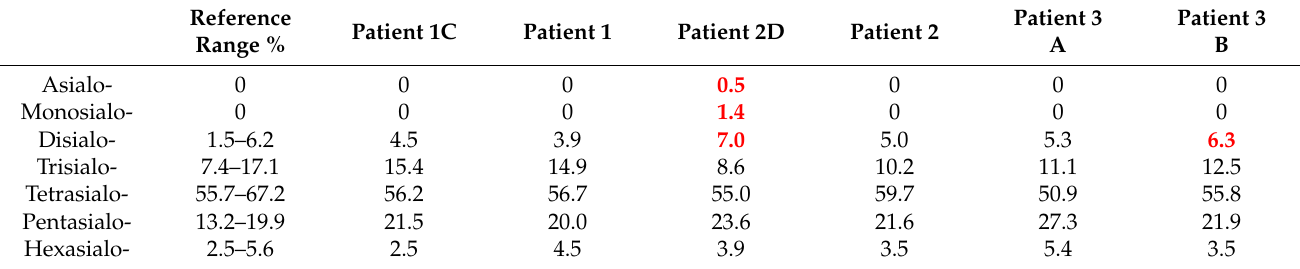
Table 1. Isoelectric focusing (IEF) of transferrin in our patients with ALG13 c.320A>G variant (CDT values exceeding the reference range are marked with red). The letter below the patient’s number corresponds to the band showed in Figure 2.